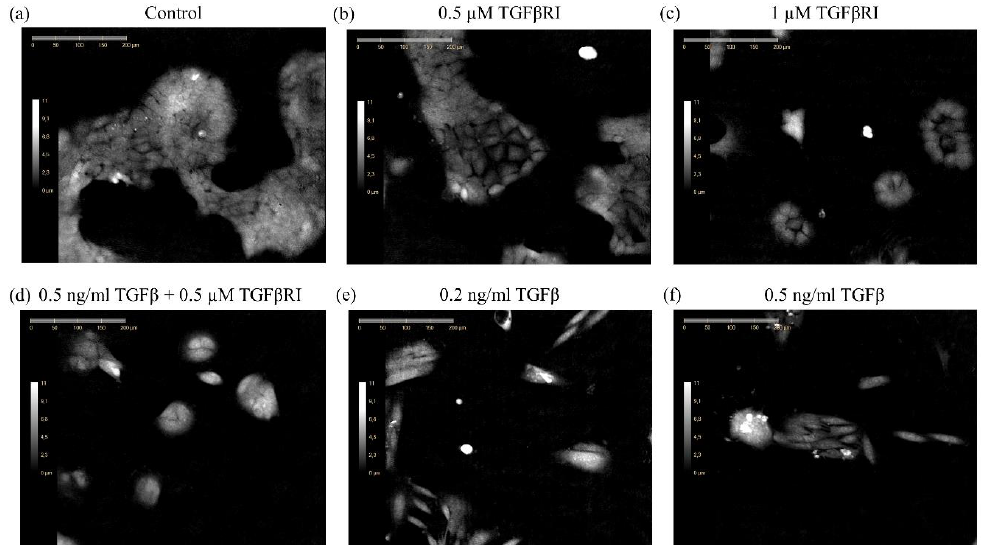
Figure 1. Treatment of NMuMG cells with TGF β induces EMT which is inhibited by the TGF β type-1 receptor inhibitor SB431542. Representative digital holographic images of NMuMG cells cultured in the absence ( a ) or presence of 0.5 ( b ) or 1 µ M ( c ) TGF β RI, the combination of 0.5 ng / mL TGF β and 0.5µM TGF RI ( d ), or 0.2 ( e ), or 0.5 ng/mL ( f ) TGFβ for 24 hours.